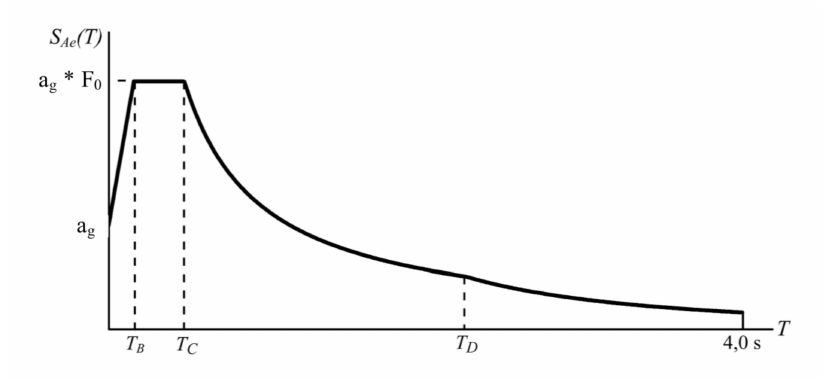
Figure 9. Seismic spectrum.